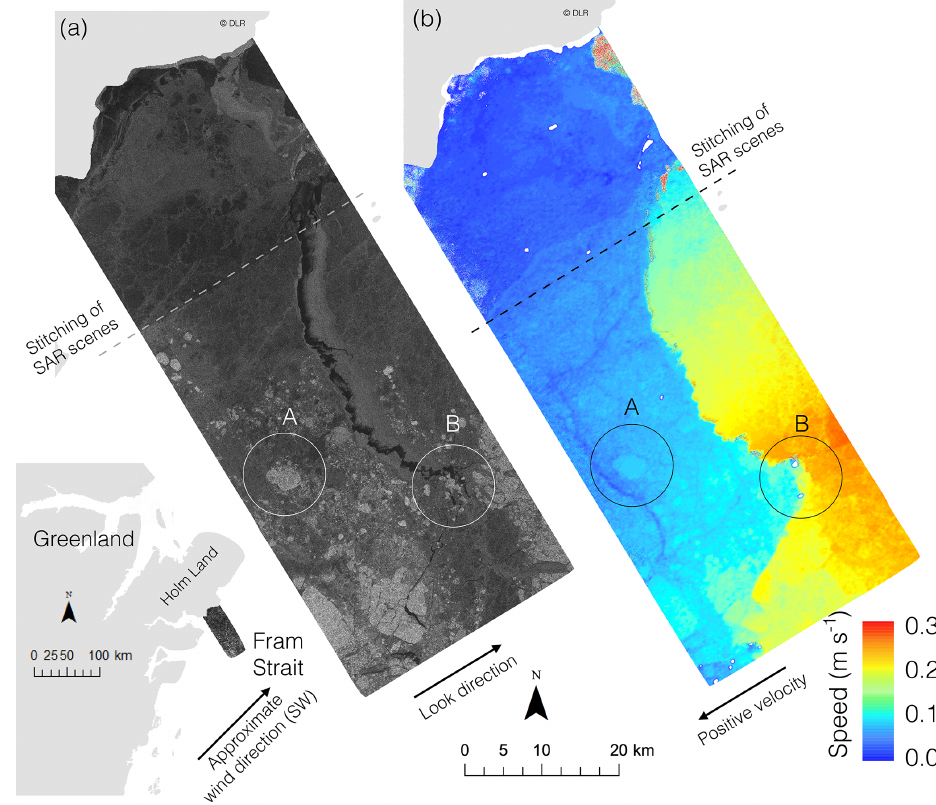
Figure 4. (a) TanDEM-X backscatter scene over Fram Strait 23 November 2015 at 17:00 UTC. (b) Look-directional component of InSAR- derived speed. Letter “A” signifies multiyear ice and “B” signifies area of icebergs. Land is masked out in light gray. White areas signify values larger than the range of the color scale due to topography (either icebergs or land topography near the coast due to a poor match with the land mask). Wind at the time of the acquisition was roughly southwesterly at 3ms − 1